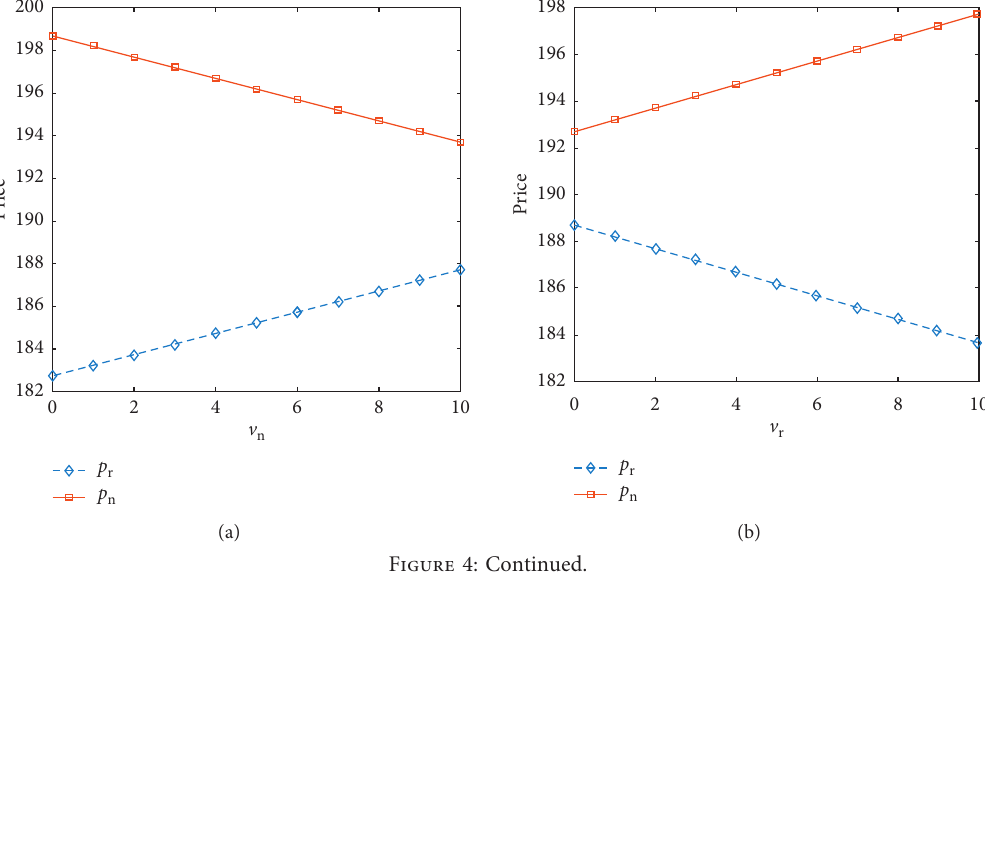
and p : (a) the influence of recycling effort e r n and p r n